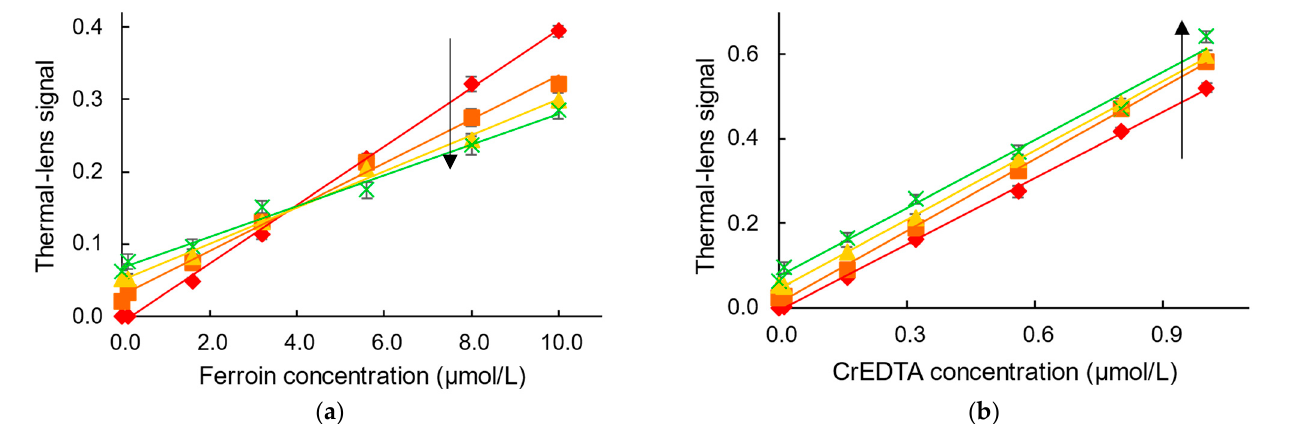
Figure 6. Calibration dependences of ( a ) ferroin and ( b ) CrEDTA at different albumin concentrations in a solution of 0.9% NaCl; red and rhombs, no albumin; orange and squares, 20 g/L; yellow and triangles, 35 g/L; and green and crosses, 50 g/L; arrows show an increase in albumin concentration. Setup, TLS-60; excitation wavelength, 514 nm, excitation power, 40 mW.